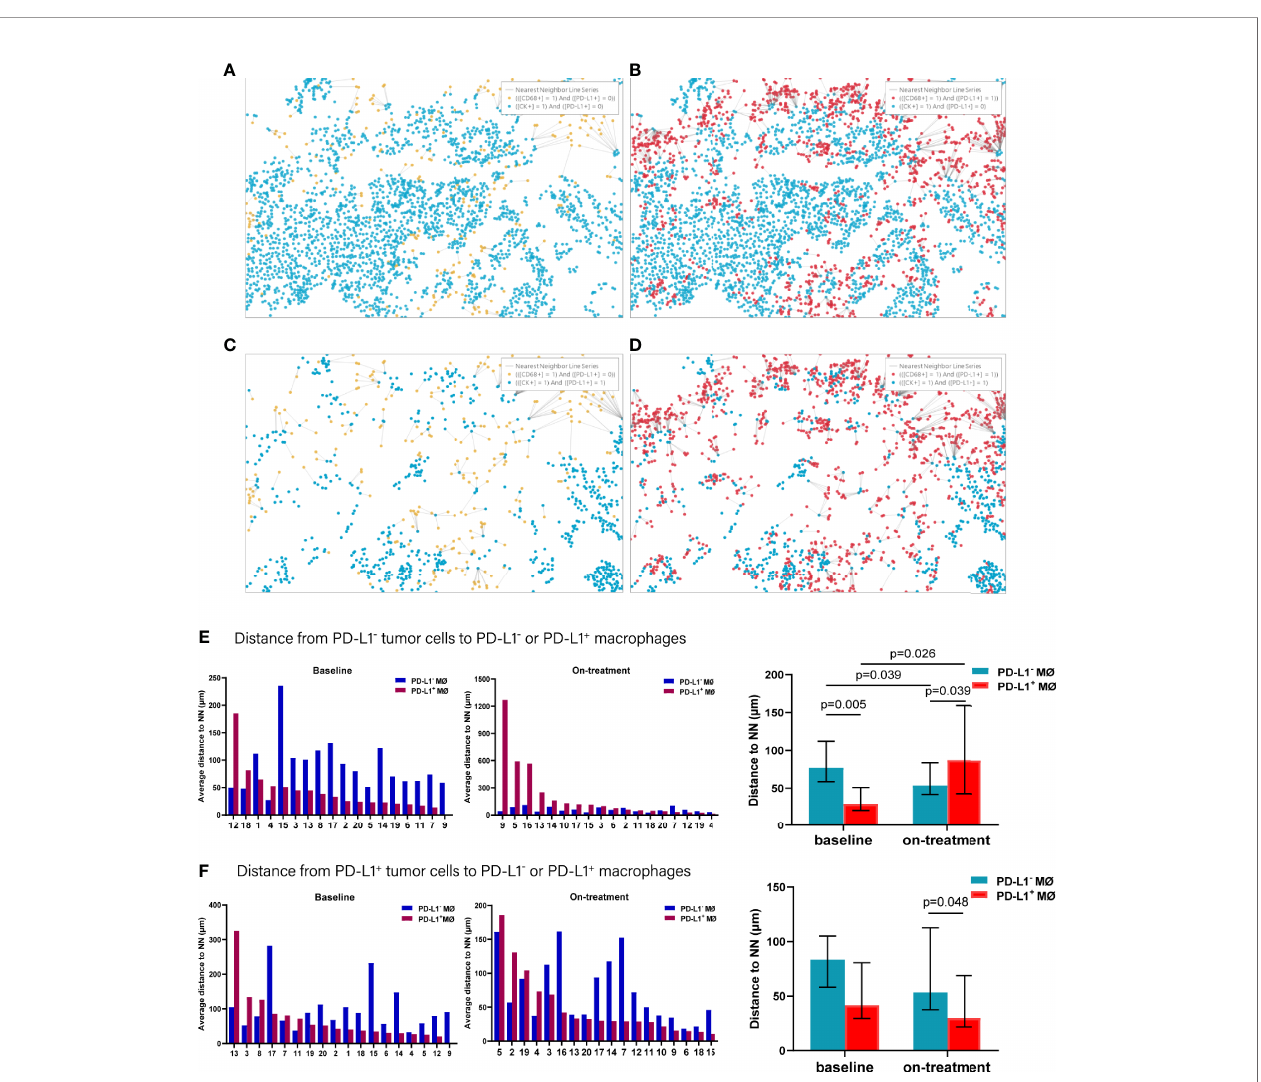
FIGURE 5 | Distance from PD-L1 - or PD-L1 + tumor cells to the nearest PD-L1 - or PD-L1 + macrophages. (A – D) Spatial analysis shown in Figure 3 . (A) Ray plot depicting the distance from each CK + PD-L1 - tumor cell to the nearest PD-L1 - macrophages. (B) Ray plot depicting the distance from each CK + PD-L1 - tumor cell to the nearest PD-L1 + macrophages. (C) Ray plot depicting the distance from each CK + PD-L1 + tumor cell to the nearest PD-L - macrophages. (D) Ray plot depicting the distance from each CK + PD-L1 + tumor cell to the nearest PD-L1 + macrophages. (E) Distances from PD-L1 - tumor cells to the nearest PD-L1 - or PD-L1 + macrophages at baseline and during treatment. (F) Distances from PD-L1 + tumor cells to the nearest PD-L1 - or PD-L1 + macrophages at baseline and during treatment. The tumors are ordered by the percentage of PD-L1 + macrophages, from highest to lowest. On-treatment, after 40 Gy radiation. p ≤ 0.05, statistically signi fi